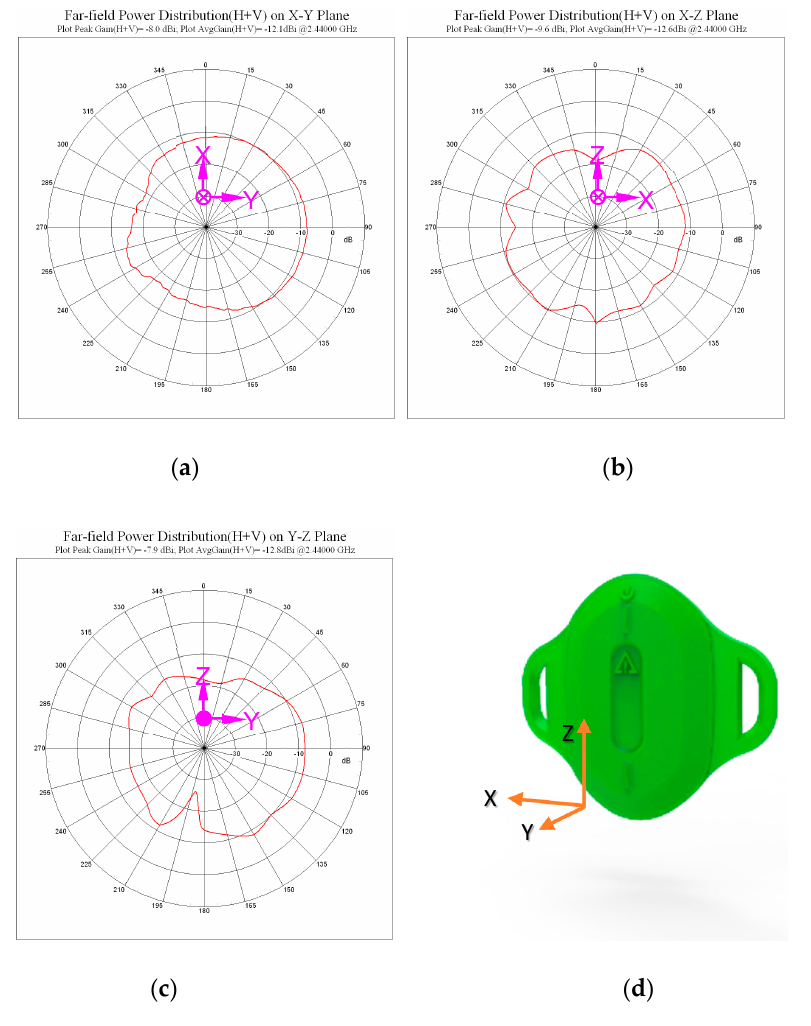
Figure 2. The BLE Tag. ( a ) Stereoscopic appearance; ( b ) back view; ( c ) internal component.